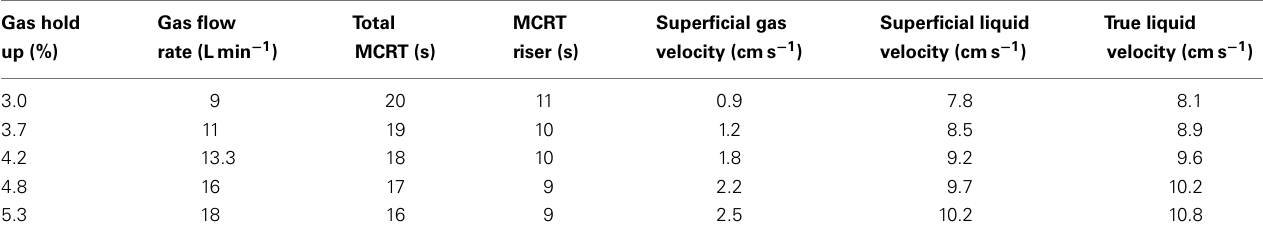
Table 4 | Calculated MCRTs for different gas flow rates .